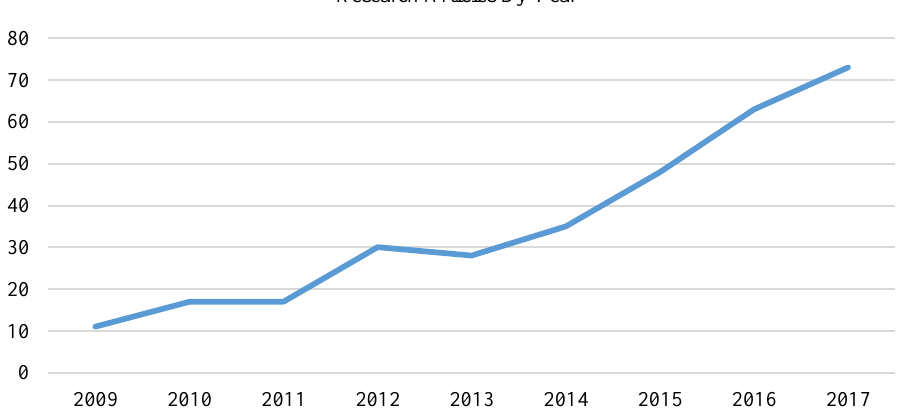
Figure 1: The focus of anti-microbial research on microorganisms from 2009 to 2017. Data adapted from the database of